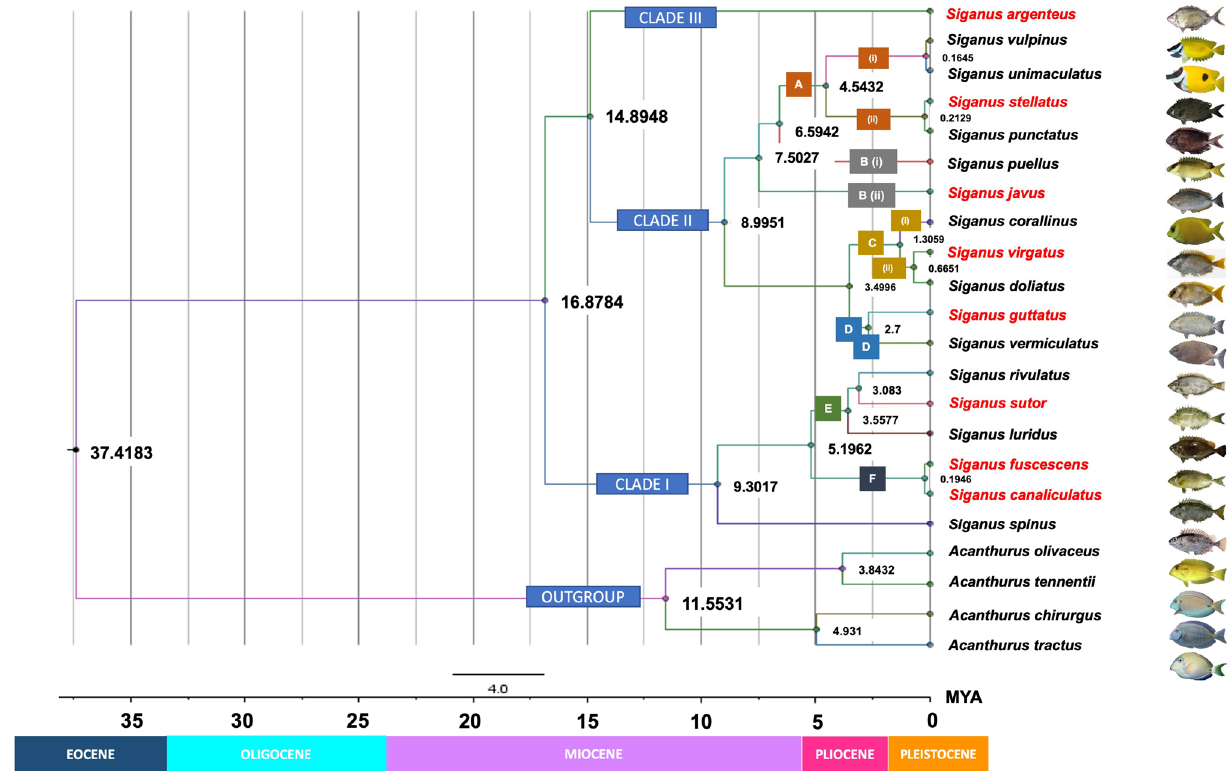
Figure 6. Time-calibrated phylogeny for Siganus species based on COI Bayesian inference. Numbers near the nodes are denoted as millions of years ago (mya), corresponding to the geologic periods. Text boxes detail the morphological or morphometric features unique to each clade and taxon. Clade I: slender-bodied, Clade II: deep-bodied, Clade III: moderately slender-bodied. A ( i ) = Head and body with no spots, snout strongly tubulated; A ( ii ) = Head and body completely covered with numerous light or dark spots, snout not tubulated; B ( i ) = Body compressed and not particularly deep, prominent black spots are present above the eyes within a dark diagonal band that extends from the chin to the nape; B ( ii ) = Body deep and compressed, no prominent black spots above the eyes. C = Have similar range of head depth at the edge of the pre-opercle as a percentage of the standard length; C ( i ) = No band is present on the head or body, snout is slightly pointed; C ( ii ) = Two dark bands are present from the chin to the nape and from the base of the pelvic fins to that of the dorsal fin, snout is blunt; D = Have similar habitat preference and ecological behavior: inhabits shallow coastal areas and river mouths and tolerate low salinity; schooling throughout life. E = No pearly spots on the head or body; F = Pearly blue spots are present on the head and body. Species or groups of species were classified based on morphological characteristics, morphometric measurements, habitat preferences, or ecological behavior. Names in red indicate species that were sampled in this study. BD = body depth; ED = eye diameter; Max. TL = maximum total length.